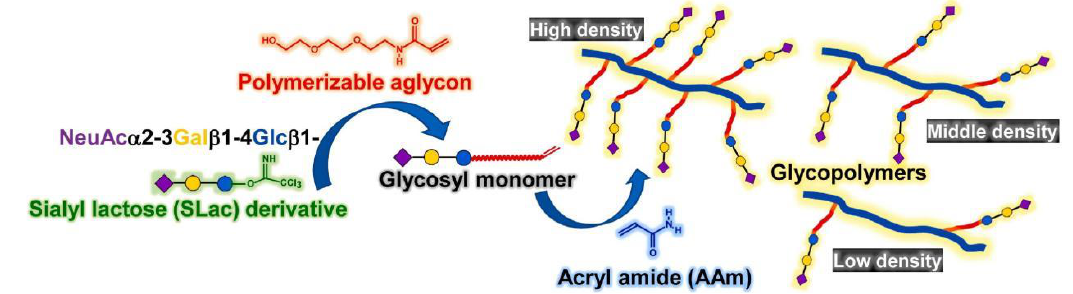
Figure 16. Construction of a synthetic scheme for multivalent glycopolymer containing SLac part. Figure reproduced from ref. [71] with permission.